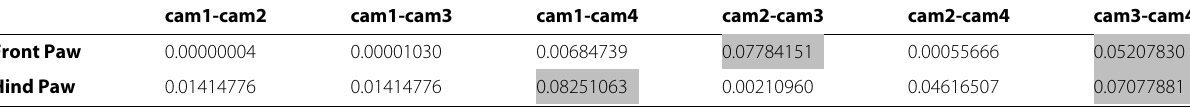
Table 1 P -value calculated by t-test for 3D reconstruction error between cameras (shown in Fig. 7) cam1-cam2 cam1-cam3 Front Paw Hind Paw